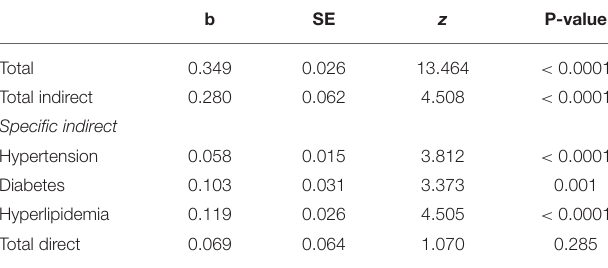
TABLE 3 | Direct and indirect associations between ln(HCC) and CAD.